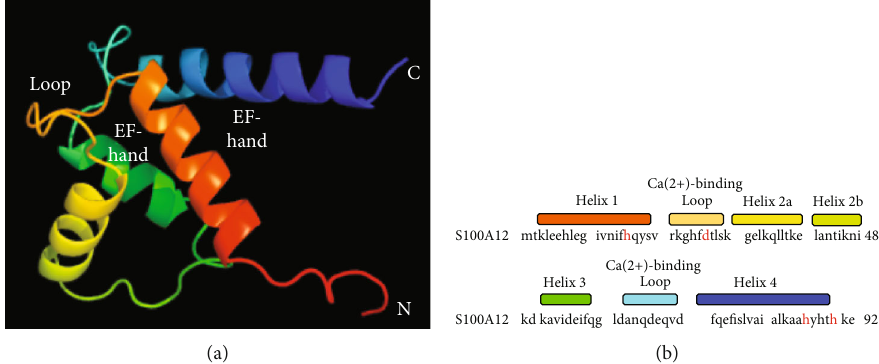
Figure 1: Model of S100A12 structure. (a) indicates PHYRE prediction of S100A12 secondary and tertiary structure. (b) indicates the primary structure beginning with helix 1 at the N terminus (pictured above in orange), calcium-binding loop 1 (pictured in yellow-orange), helix 2 (pictured in yellow), helix 3 (pictured in green), calcium-binding loop 2 (pictured in turquoise), and helix 4 (pictured in blue). The metal- binding residues which comprise the dimer interface are highlighted in red in the primary structure sequence. The two EF-hand motifs, similar in structure to a thumb and fore fi nger, are pictured in orange/yellow and green/blue, respectively. Metal-binding residues are highlighted in